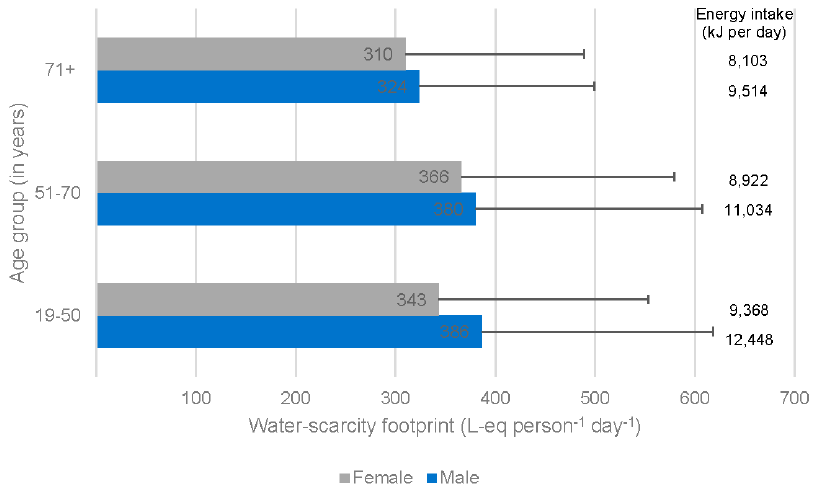
Figure 1. Water-scarcity footprint of Australian adult diets. Results are based on 9341 individual daily diets reported in the Australian Health Survey and are shown separately for females and males and for three age groups. Bars indicate the standard deviation. The dietary energy intake is also shown.